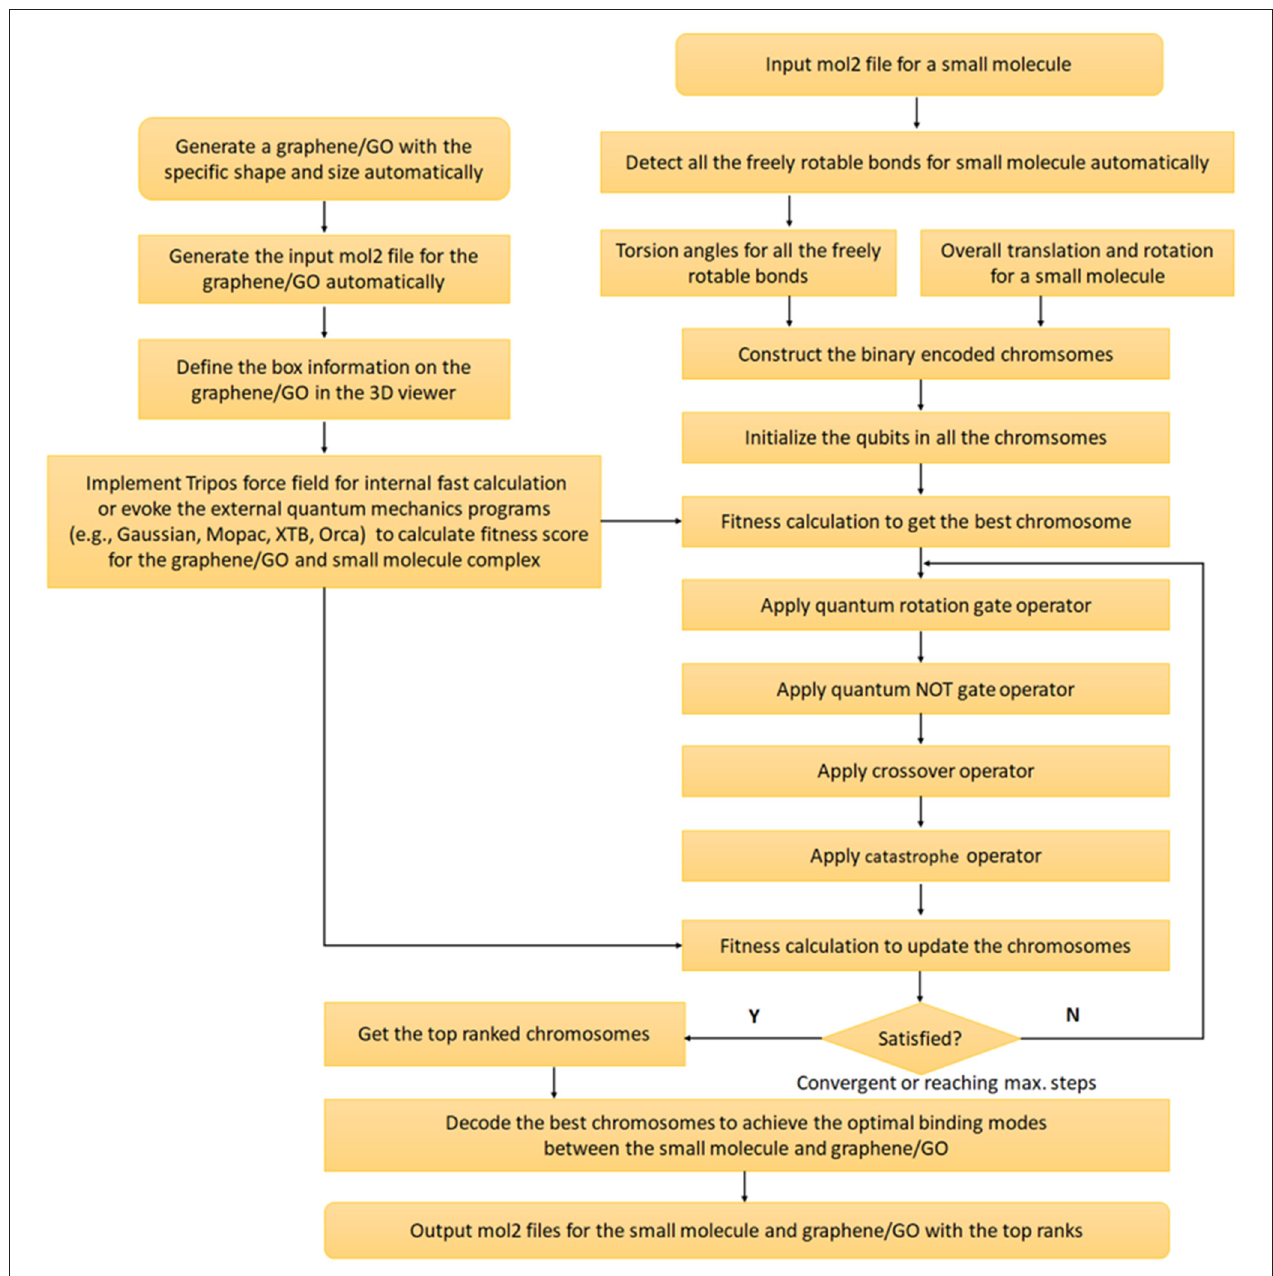
FIGURE 3 | Implementation workflow of the quantum genetic algorithm (QGA) guided prediction of graphene-based drug delivery system (GDDS).